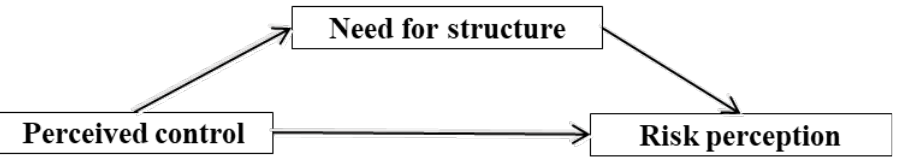
Figure 1. Hypothesized relationship among perceived control, need for structure, and risk percep- tion. H1: An individual’s perceived control can negatively predict their risk perception of GM foods. H2: The need for structure plays a mediating role between perceived control and risk perception of GM foods. In addition, the perceived risk of GM foods positively predicted individuals’ ten- dency to buy fewer GM foods [39]. Hence, we want to explore whether people with a lower sense of control would buy fewer GM foods. Since the purchase of GM foods is also inconsistent with the demand for structure, we assume that (see also Figure 2): H3: Individua ls’ perceived control can positively predict their willingness to buy genetically mod- ified food. H4: Risk perception mediates the relationship between perceived control and GM purchase inten- tion. Figure 2. Hypothesized relationship among perceived control, risk perception, and purchase inten- tion. We tested the above hypotheses through two studies: In Study 1, we tested H1 and H2 (dependent variable: risk perception of GM food), and in Study 2, H3 and H4 (depend- ent variable: intent to purchase GM food) were examined. We aimed to investigate risk perception and purchasing behavior to understand whether the individuals’ acceptance of genetically modified food can be explained from a psychological and behavioral per- spective. Our study used Chinese participants since genetically modified crops are com- mercially grown in China, and the general public is familiar with them [40], being exposed to them almost daily. 3. Study 1 The purpose of Study 1 is to test H1 and H2, that is, the predictive effect of perceived control on the risk of GM food perceived by individuals and the mediating effect of the need for structure. To this end, we collected data through a questionnaire method and observed the relationship between variables. 3.1. Study 1 Methods 3.1.1. Participants We conducted a paper-and-pencil survey on college students in a Chinese university in Shaanxi province, and 436 undergraduate students were recruited to fill in the ques- tionnaire voluntarily. All participants were fully informed that their anonymity was